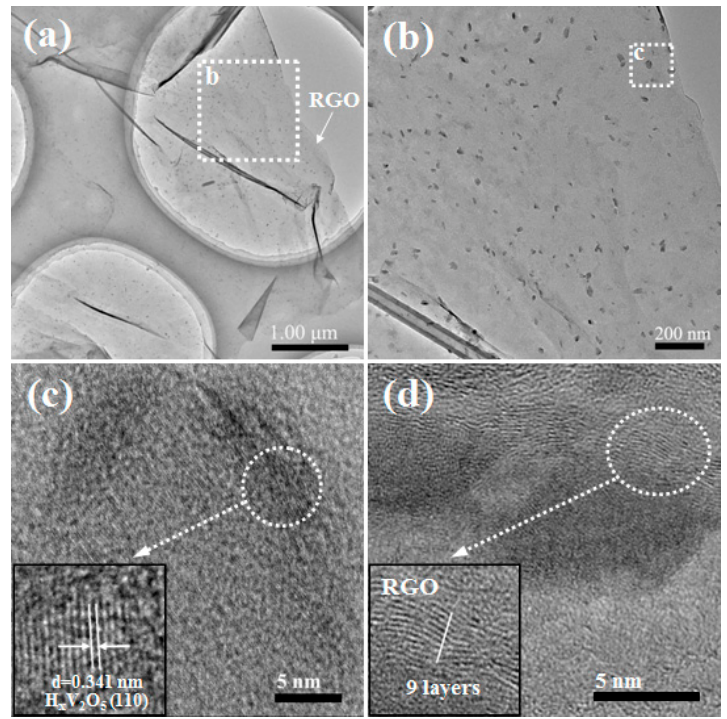
Figure 3. Transmission electron microscopy (TEM) images ( a ) and ( b ) and high-resolution TEM (HRTEM) ( c ) and ( d ) of the VG ‐ N ‐ A300.